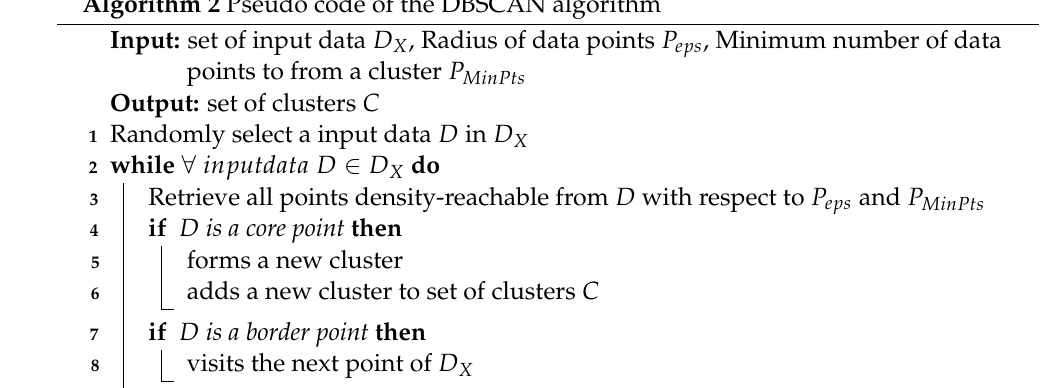
Algorithm 2 Pseudo code of the DBSCAN algorithm